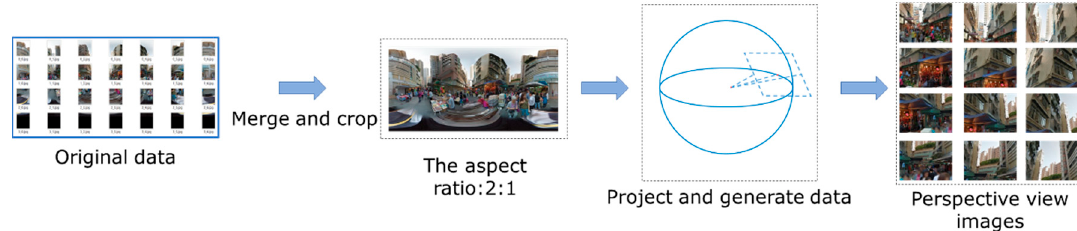
Figure 2. The street view panorama preprocessing Figure 2 . The street view panorama preprocessing flow.